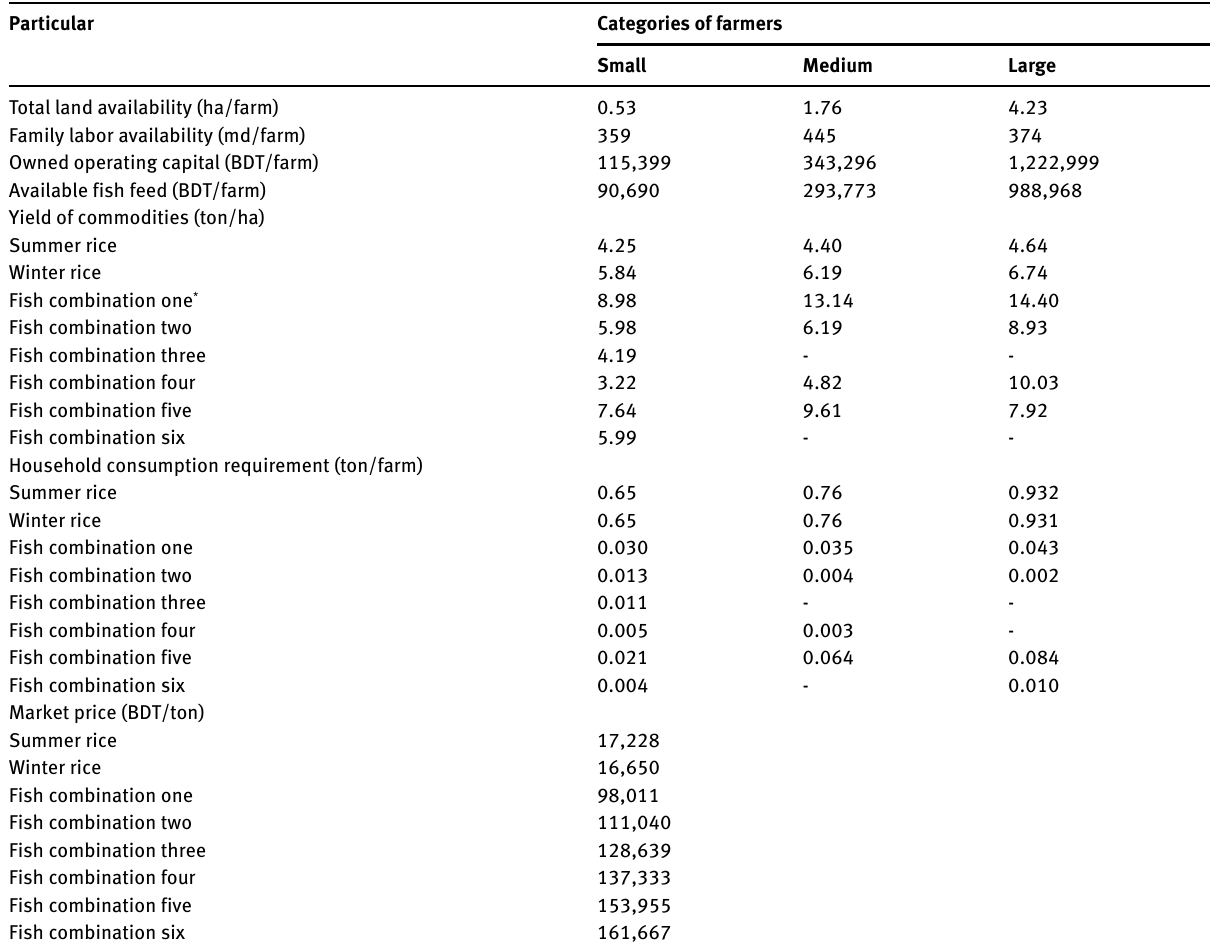
Table 2: Parameters considered in the model